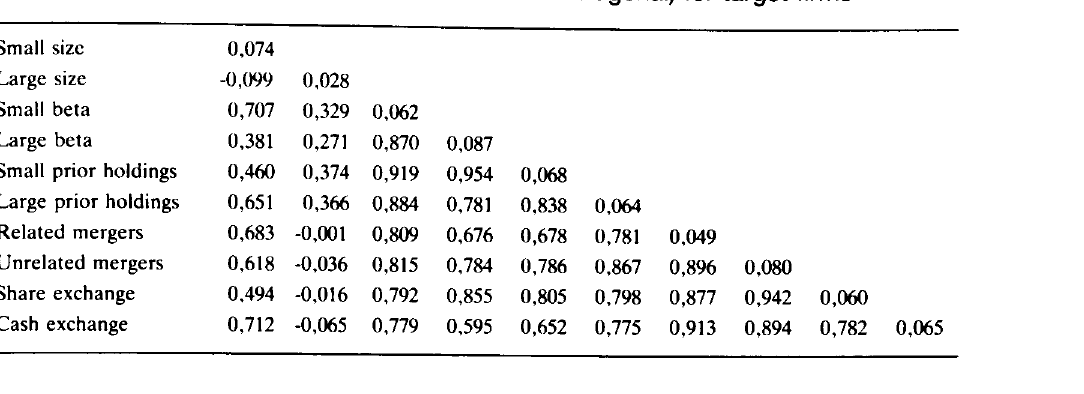
Table 2 Correlation matrix (standard deviations on diagonal) for target